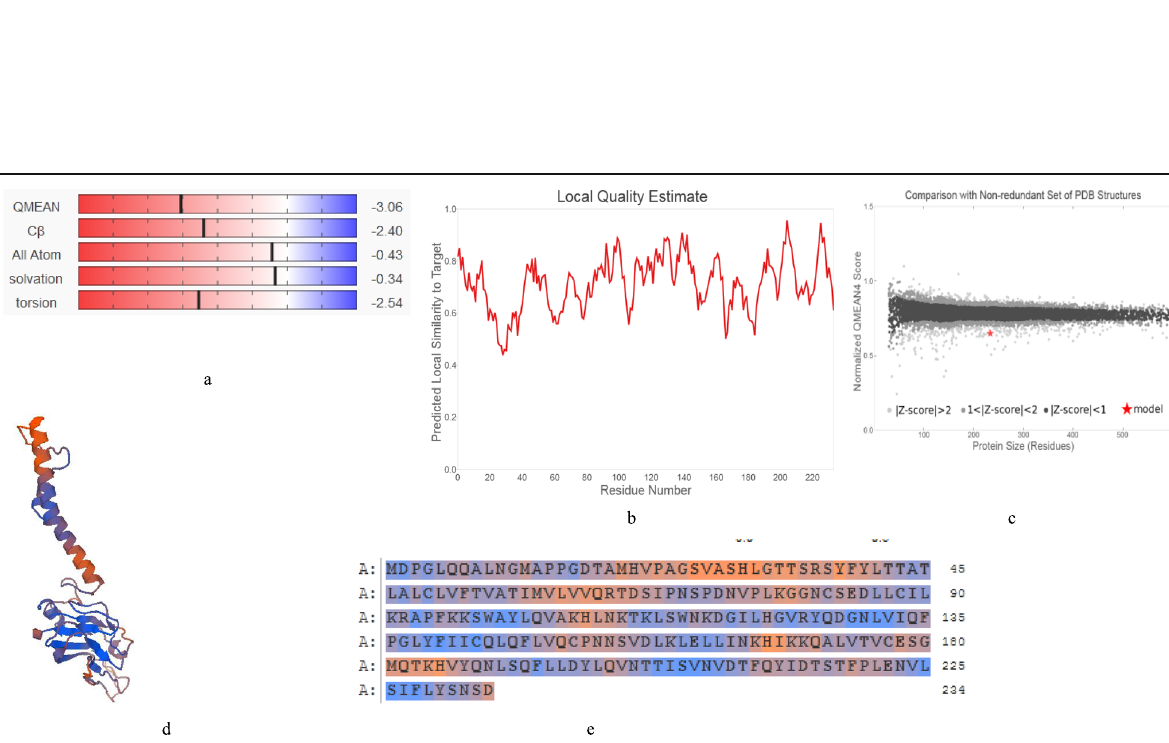
Fig. 8 Qualitative model energy analysis showing the a Global Quality Score, b local quality estimate, c comparison with a non-redundant set of PDB structures, d predicted 3d structure, and e sequence coloured by local quality. The local quality increases with the colour gradient from orange (low quality) to blue (high